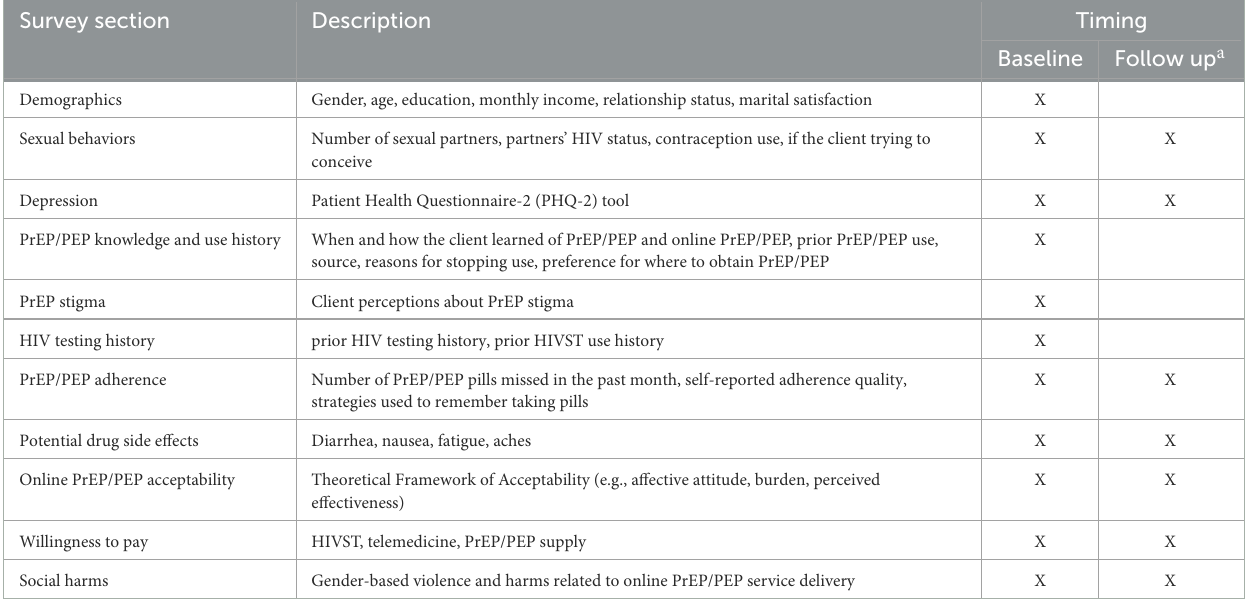
TABLE 2 Behavioral data collection activities at enrollment (Baseline) and follow-up visits. Survey